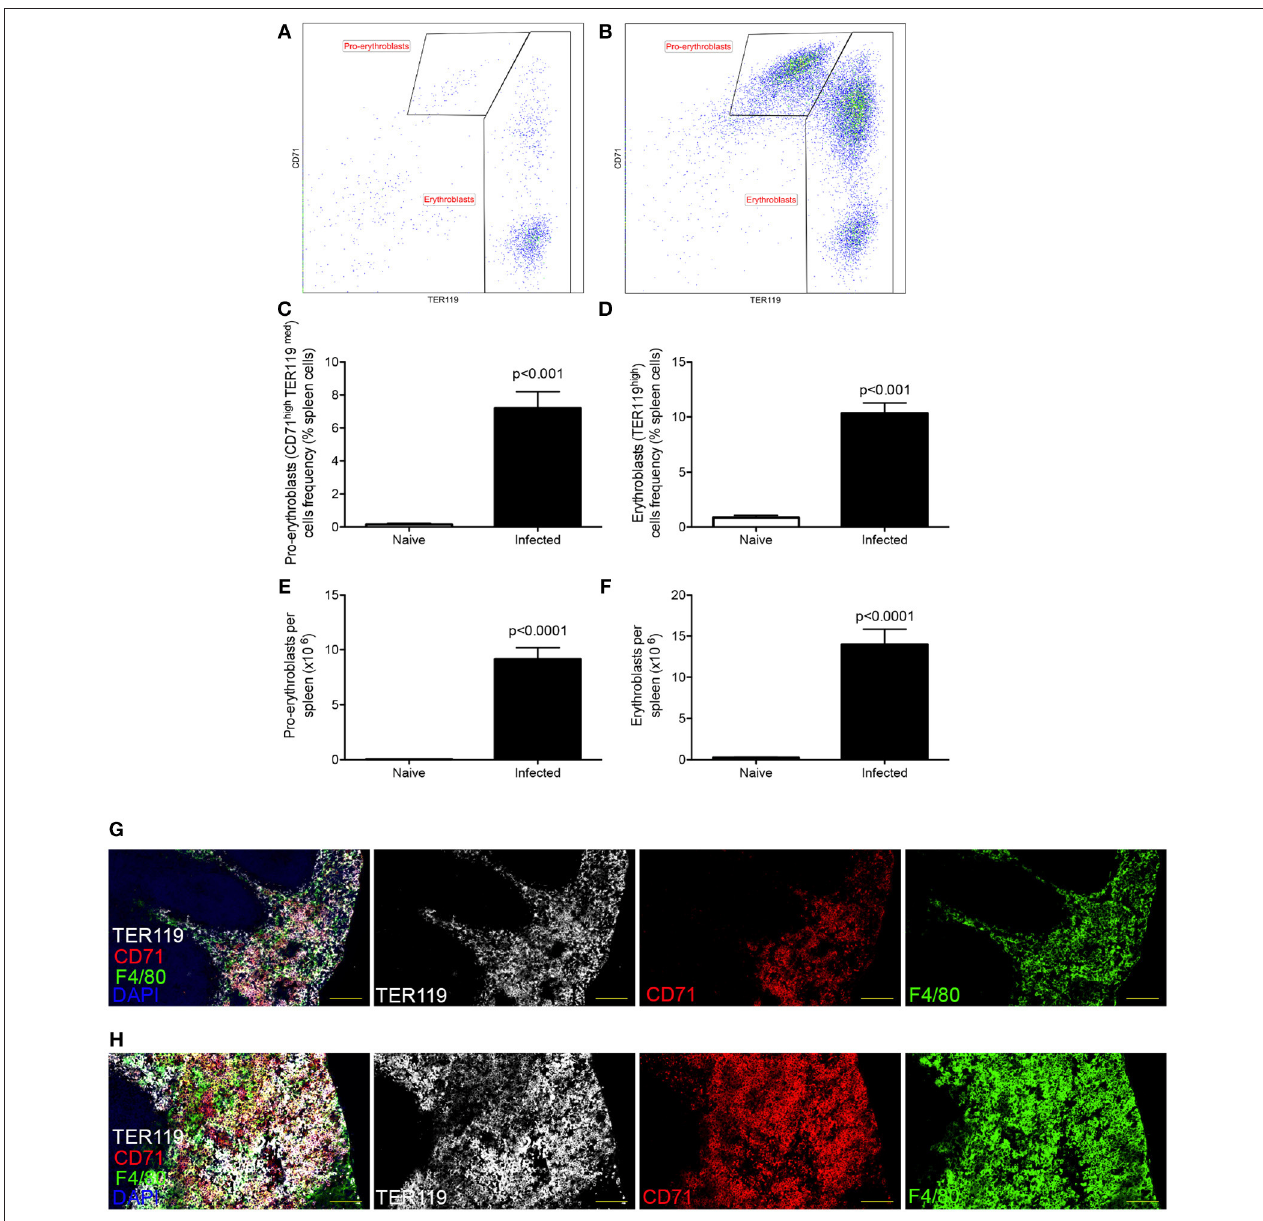
FIGURE 1 | L. donovani infection induces extramedullary erythropoiesis in the spleen. (A,B) Gating strategy for identification of pro-erythroblasts (CD45 − CD71 high TER119 low ) and erythroblasts (CD45 − CD71 high / low TER119 high ) in the spleens of naïve (A) and infected (B) mice. Plots are gated on CD45 − live cells and equal number of live cells. (C) Frequency of pro-erythroblasts in the spleen. (D) Frequency of erythroblasts in the spleen. (E) Absolute number of pro-erythroblasts per spleen. (F) Absolute number of erythroblasts per spleen. Absolute numbers were calculated by multiplying the cell frequencies by the total numbers of cells per spleen. (G,H) Representative histology of spleens from control (G) and infected (H) mice. Sections were stained for F4/80 (green), TER119 (white), CD71 (red), and counterstained with DAPI (Blue). F4/80 demarcates the red pulp. All mice were infected for 28 days. Data represent mean ± SEM (unpaired t -test with Welch’s correction; n = 8 mice per group from two independent